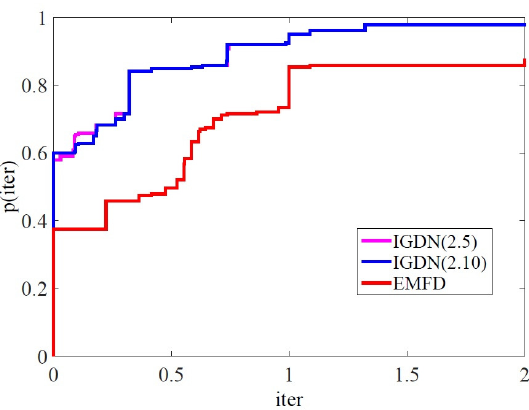
Figure 1. Performance profile of IGDN versus EMFD [8] with respect to iter .